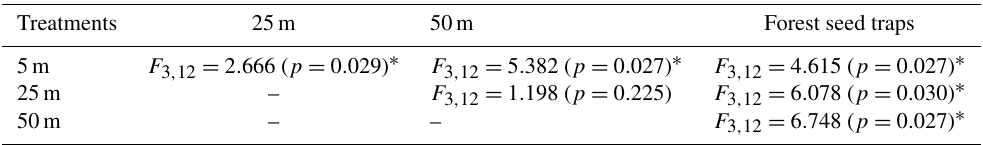
Table 3. One-way statistical test PERMANOVA, concerning the composition of seed rain in perches (5, 25, and 50m) and forest seed traps, at different distances ( p < 0.05).